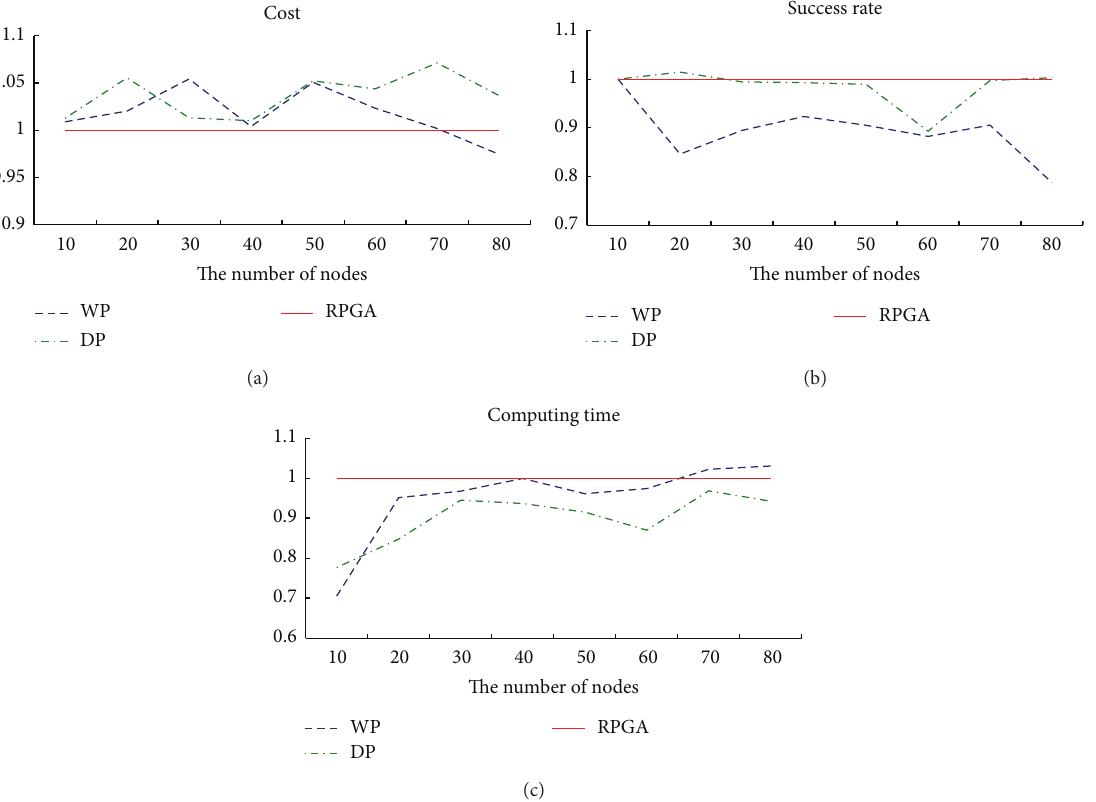
Figure 10: Comparison with three methods for different numbers of network nodes in percentage relative to the RPGA on (a) cost, (b) success rate, and (c) CPU